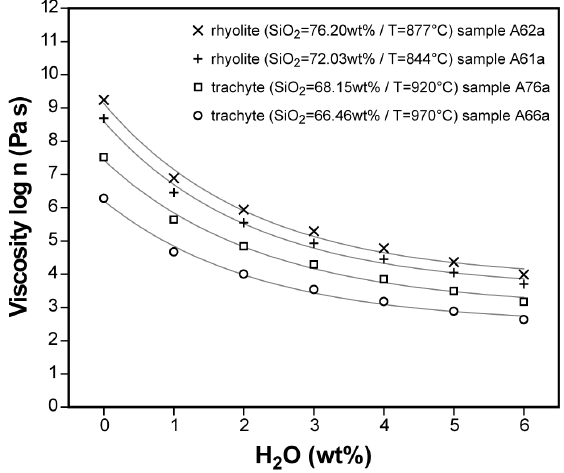
Fig. 4 – Viscosity estimation for Iricoumé samples as a function of water content. Solid lines represent best fit